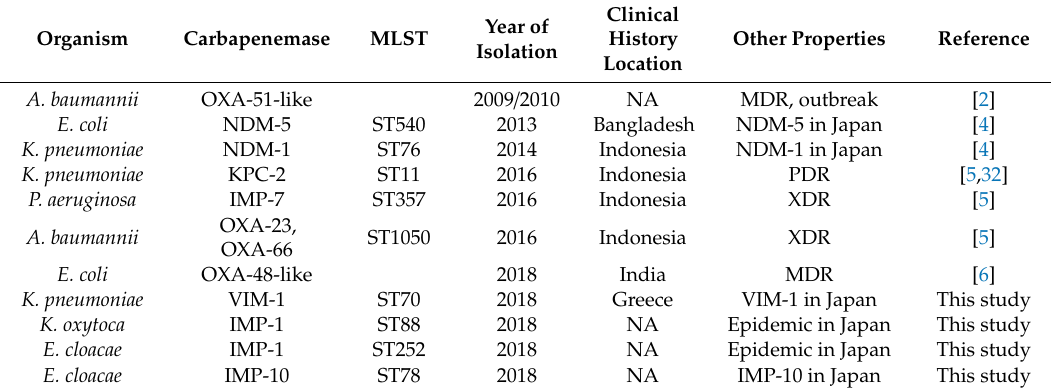
Table 3. Carbapenemase-producing Gram-negative organisms isolated at Teikyo University Hospital, Tokyo,